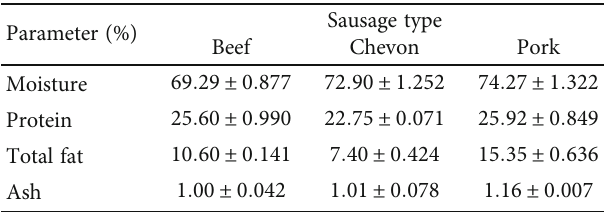
Table 3: Hedonic scores ∗ for each sausage and attribute in blind